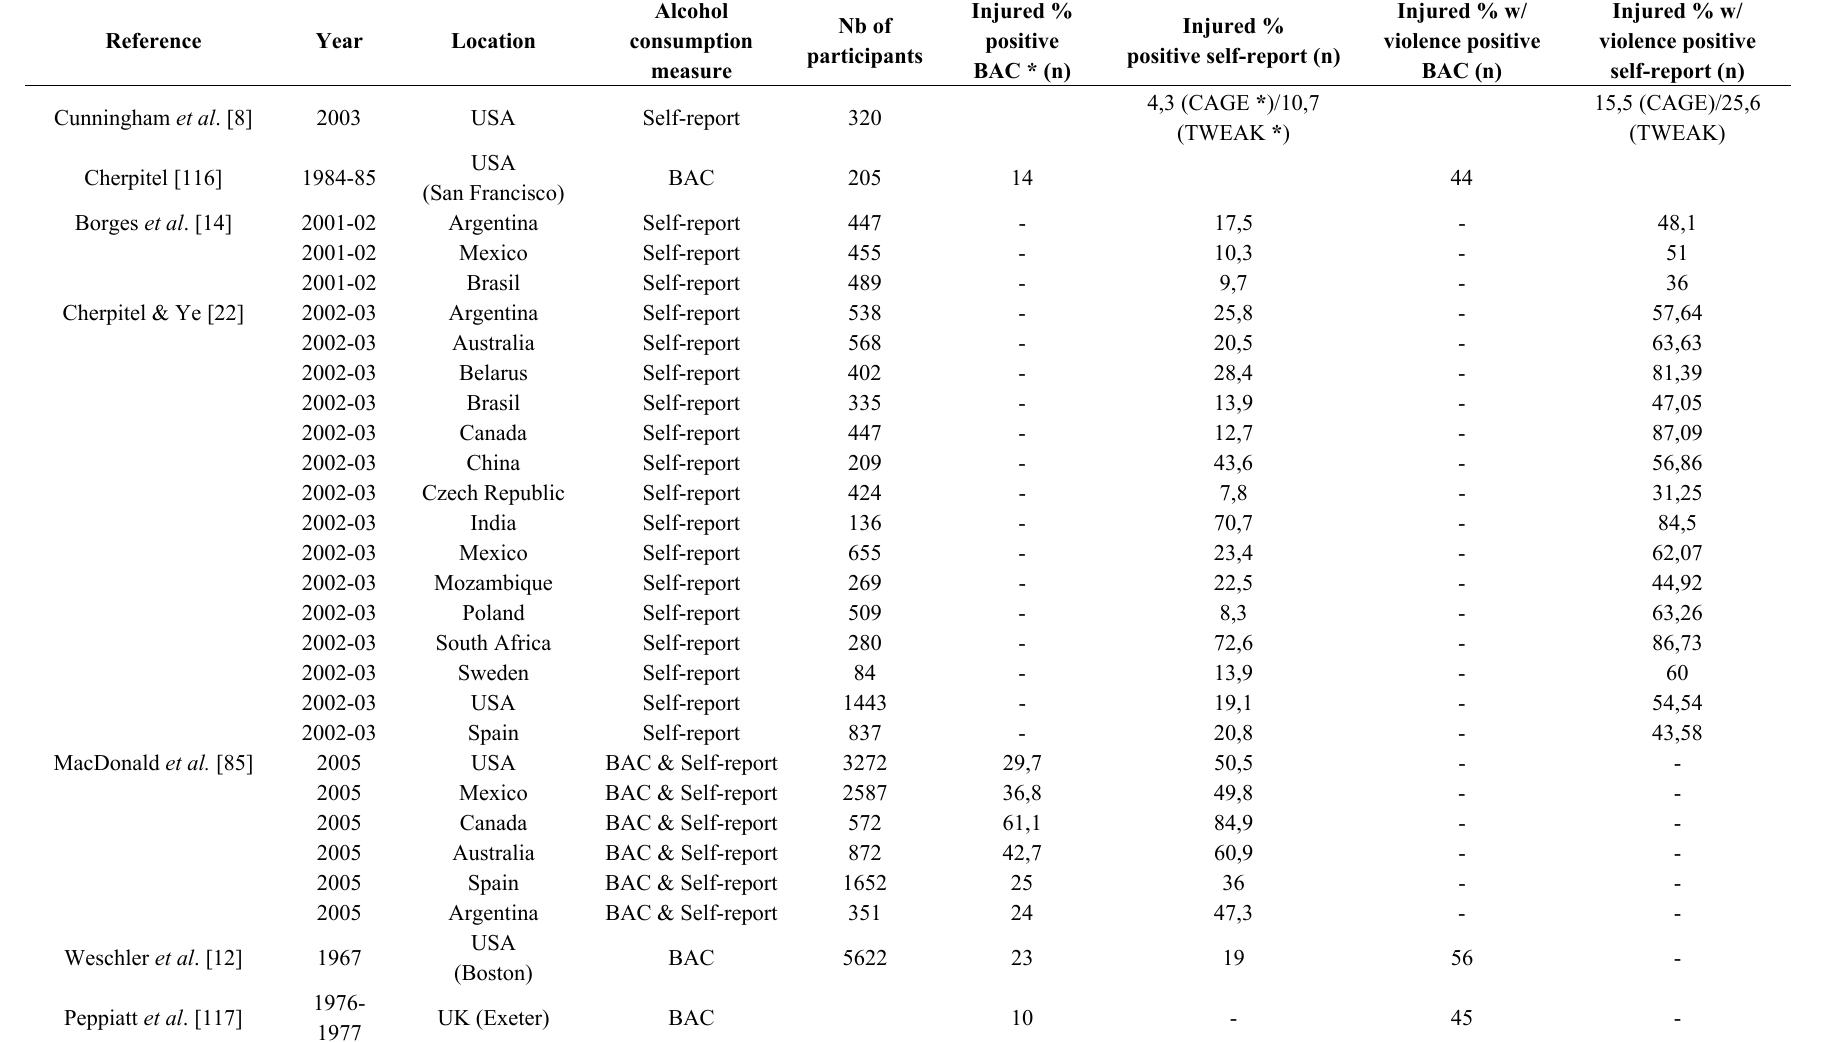
Table 1. ER studies measuring self-report of alcohol consumption and BAC among probability samples of injured and violence-related injured